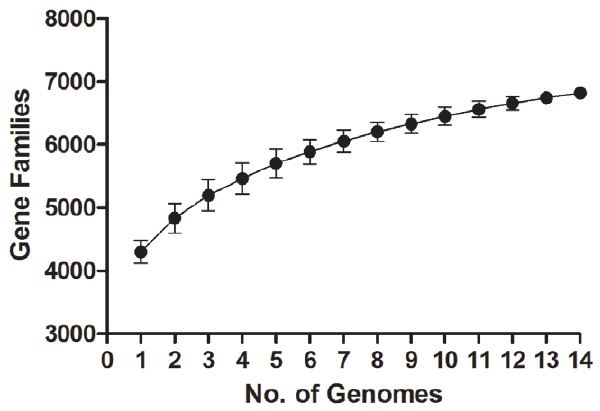
Figure 3. Graph representing the rarefaction of the Cronobacter pan genome, generated using the 14 Cronobacter genomes included in this study.